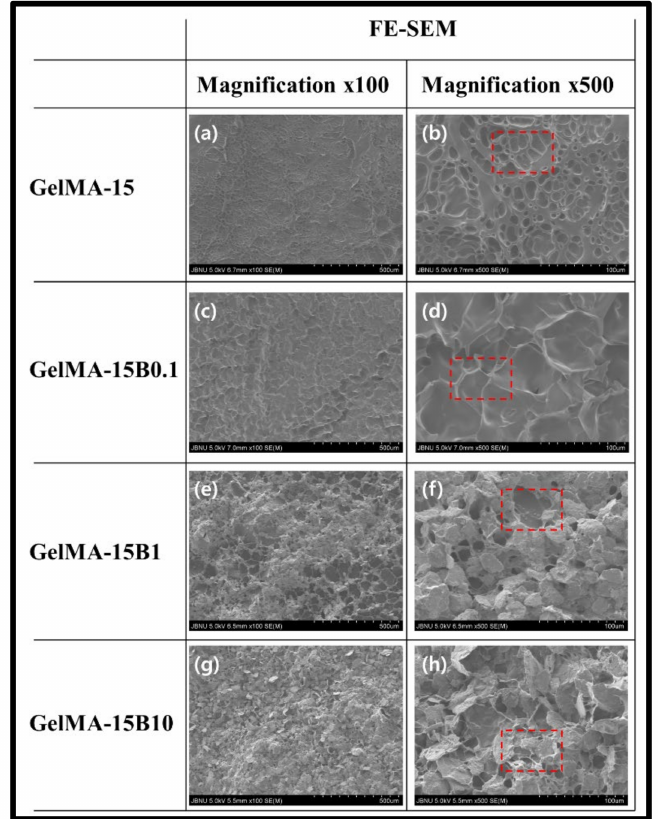
Figure 3. FE-SEM images on surface of ( a , b ) GelMA-15 and ( c , d ) GelMA-15B0.1, ( e , f ) GelMA-15B1 and ( g , h ) GelMA-15B10 hydrogels, at different magnifications ( × 100 and × 500). Red area: surface morphology according to BCP capacity increase.